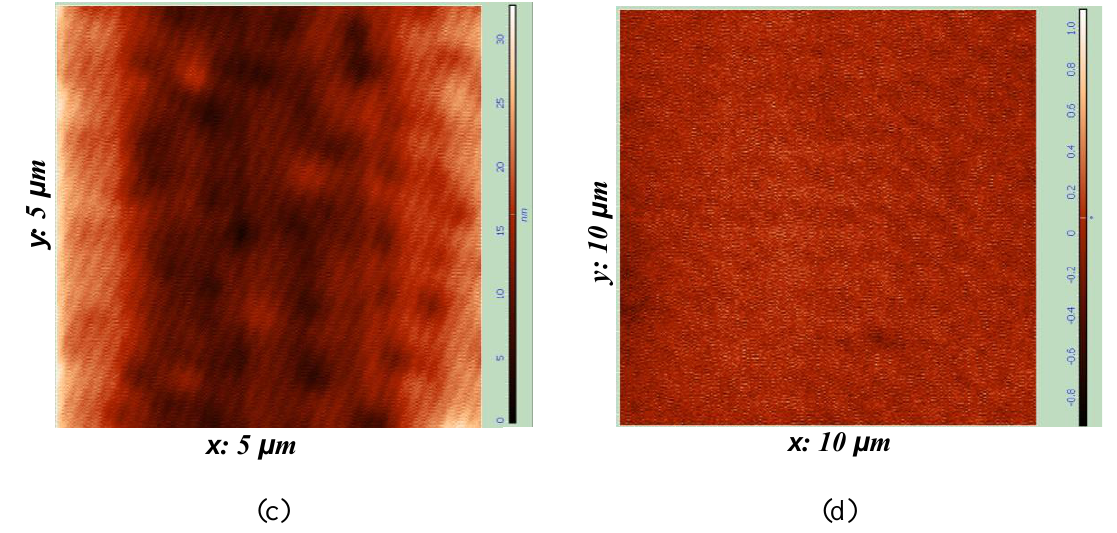
Figure 3. Representative polarized light microscopy (POM) ( a ), and atomic force microscopy (AFM) topography ( b,c ) and phase contrast ( d ) images of the POF film casted from chloroform solution.